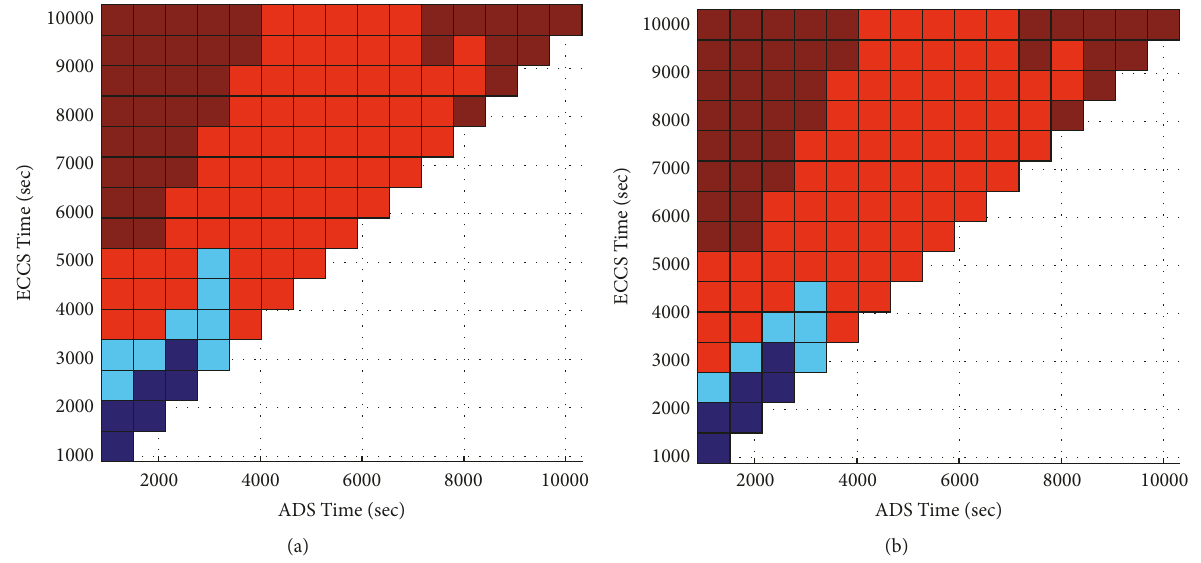
Figure 6: Fuel damage state (a) at the time of water injection (ECCS time) and (b) at the time of transition ( 𝑇 𝑡𝑟 ) as predicted by MELCOR 2.2.